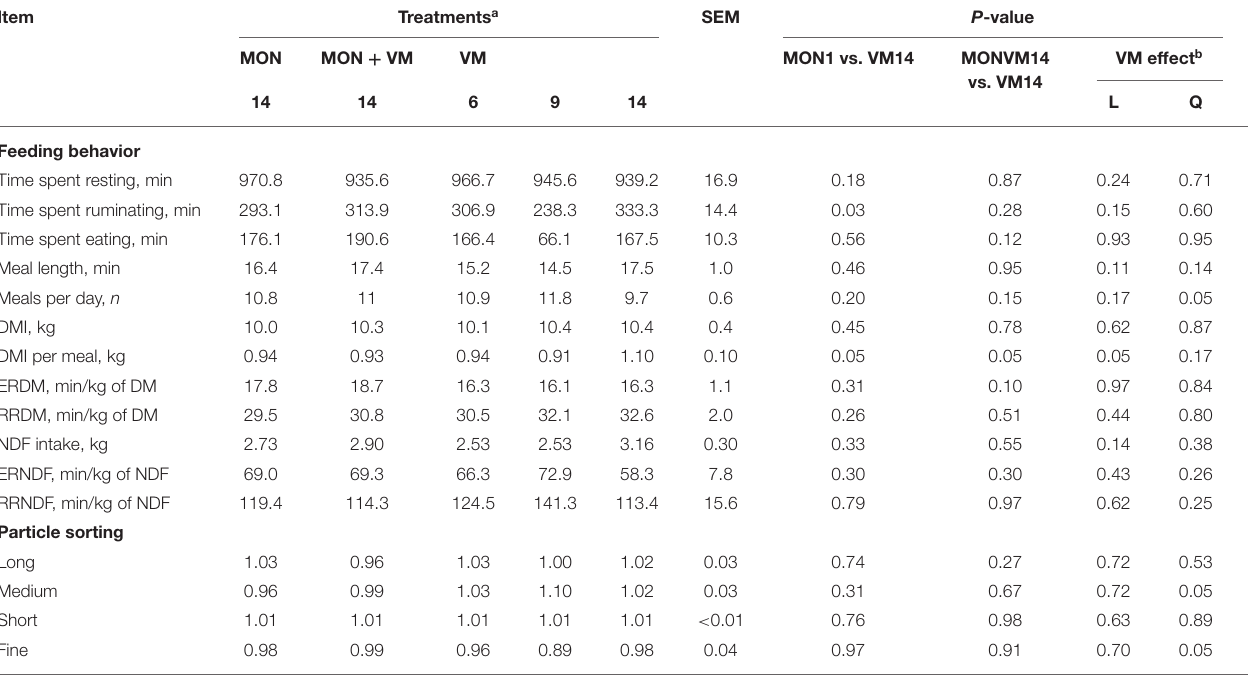
TABLE 4 | Feeding behavior and particle sorting of Nellore yearling bulls consuming high-concentrate diets containing sodium monensin (MON), virginiamycin (VM), or both in the finishing period (after 60 days on feed). Item Treatments a SEM P -value MON MON + VM MON1 vs.